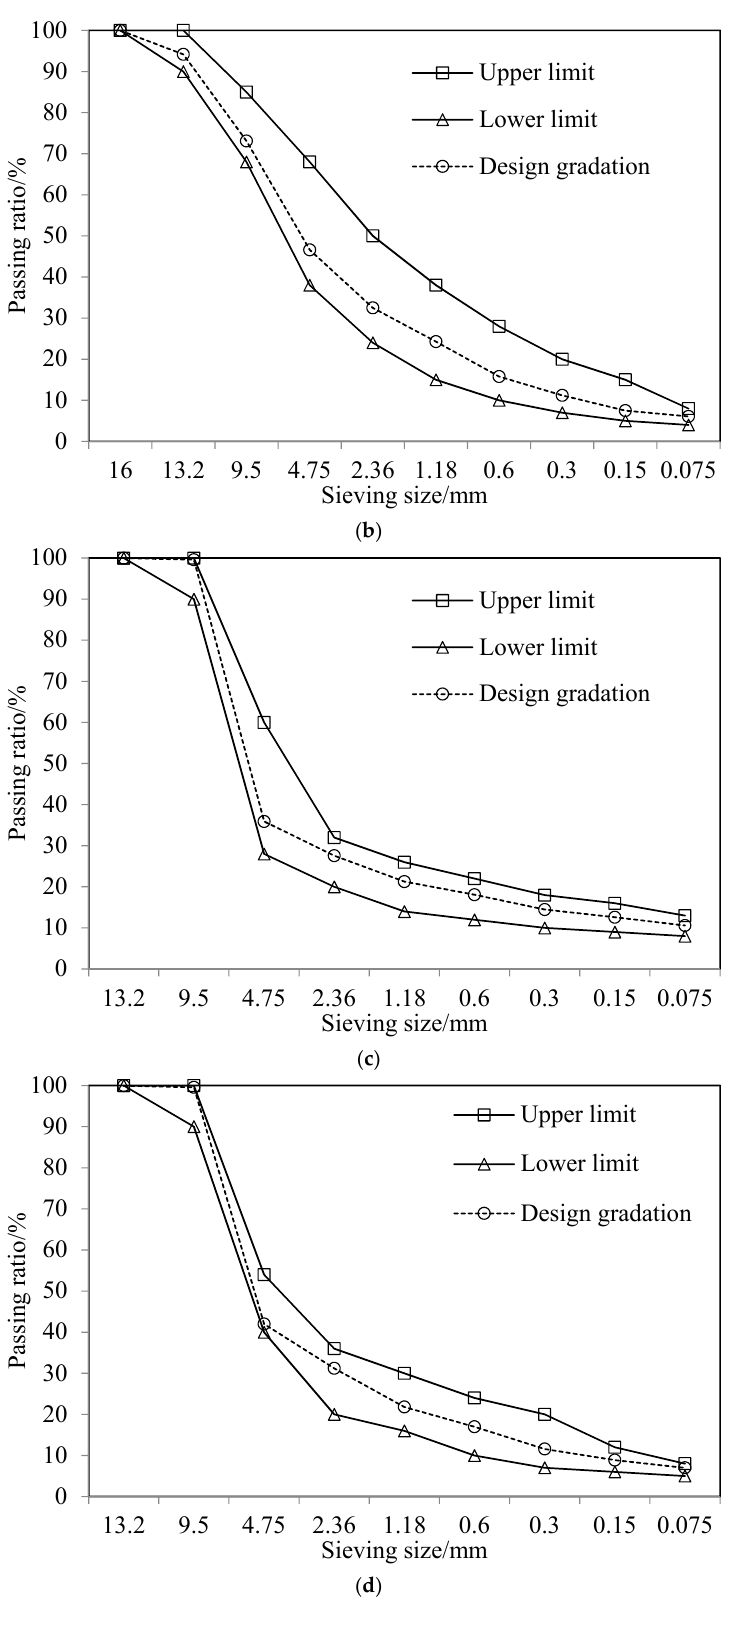
Figure 1. The designed gradation for different asphalt mixtures: ( a ) SMA13; ( b ) AC13; ( c ) SMA10; ( d ) UWM10 and M ‐ UWM10.